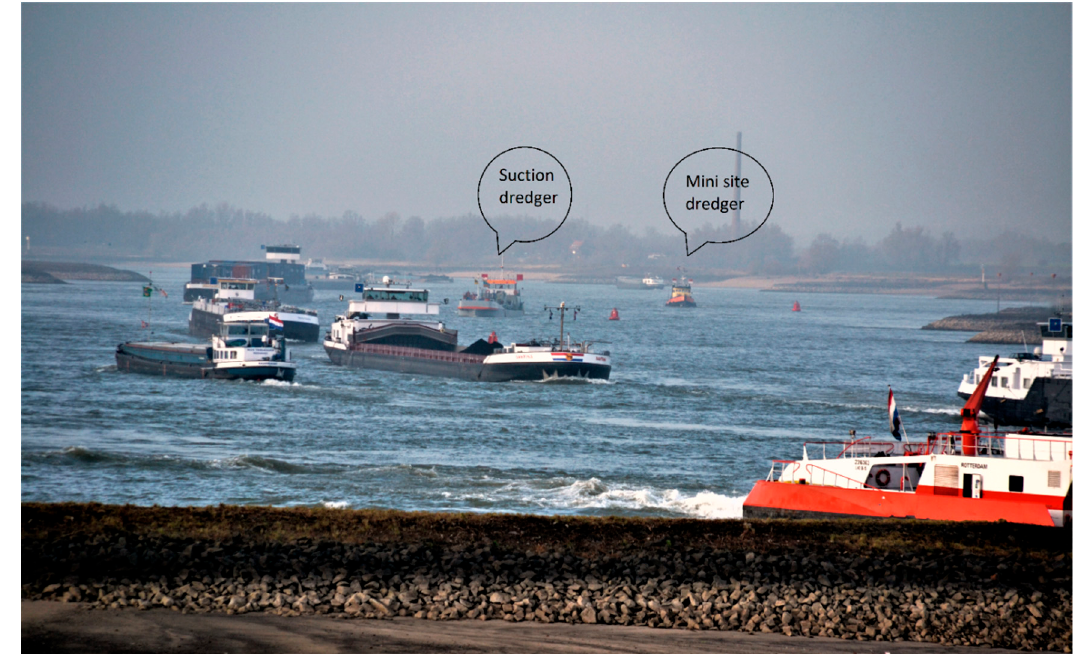
Figure 20. Traffic pressure at Erlecom during low water levels (November 2011). Figure 20. Tra ffi c pressure at Erlecom during low water levels (November